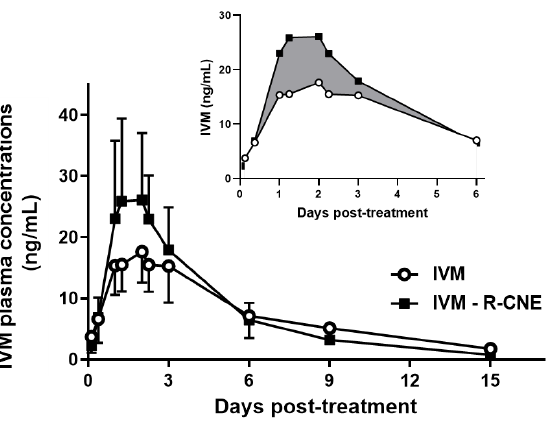
Figure 1. Mean plasma ivermectin (IVM) concentrations ( ± SD) obtained after subcutaneous adminis- tration either alone or in combination with carvone (R-CNE) (three oral doses of 100 mg/kg every 24 h) to lambs (n = 7 per group). Table 1. Plasma pharmacokinetic parameters of ivermectin (IVM) in plasma (mean ± SD) obtained after subcutaneous administration (0.2 mg/kg) either alone or in combination with carvone (R-CNE) (three oral doses of 100 mg/kg every 24 h) to lambs ( n = 7 per group). Kinetic Parameters